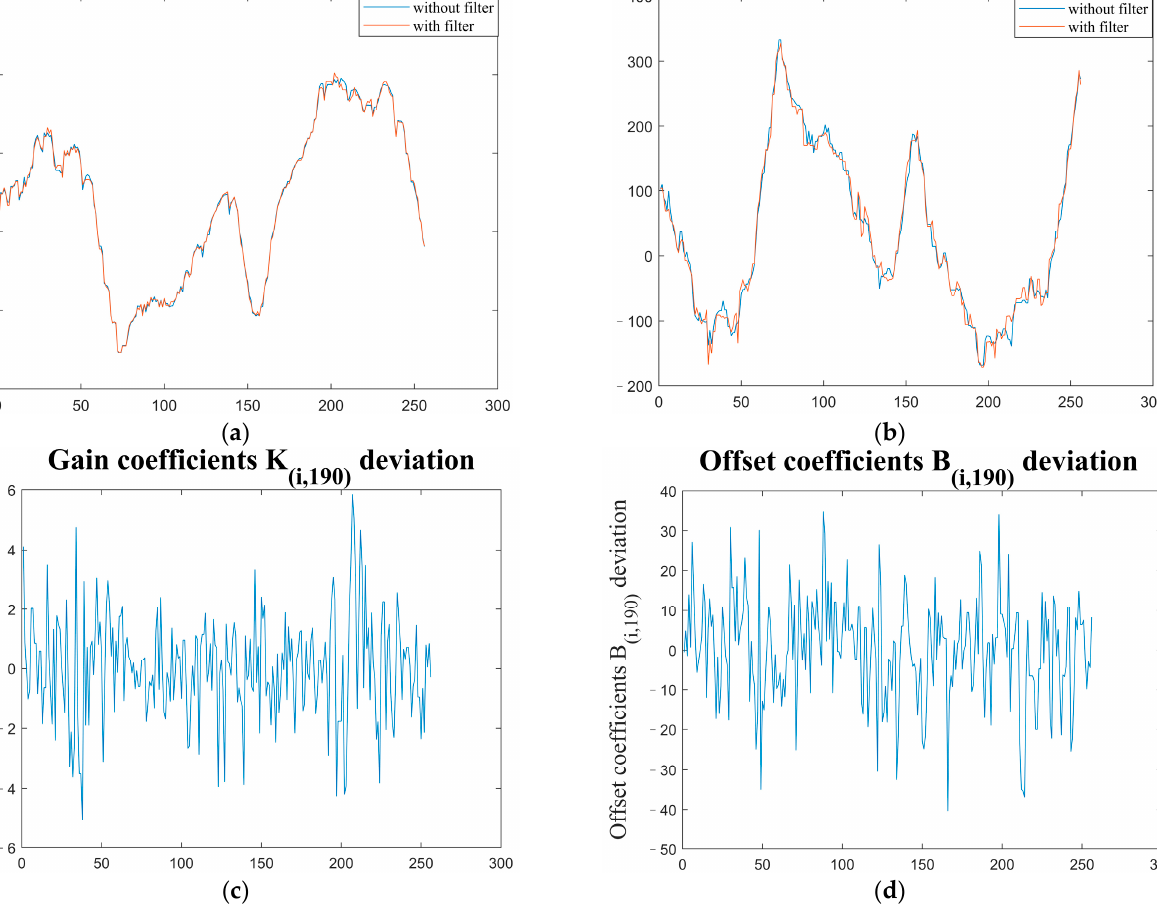
Figure 18. Comparison of correction coefficients in the 190th column: ( a ) correction gain coefficients K i,j in the 190th column; ( b ) correction offset coefficients B i,j in the 190th column; ( c ) correction gain coefficients K i,j deviation in 190th column; ( d ) correction offset coefficients B i,j deviation in 190th column.